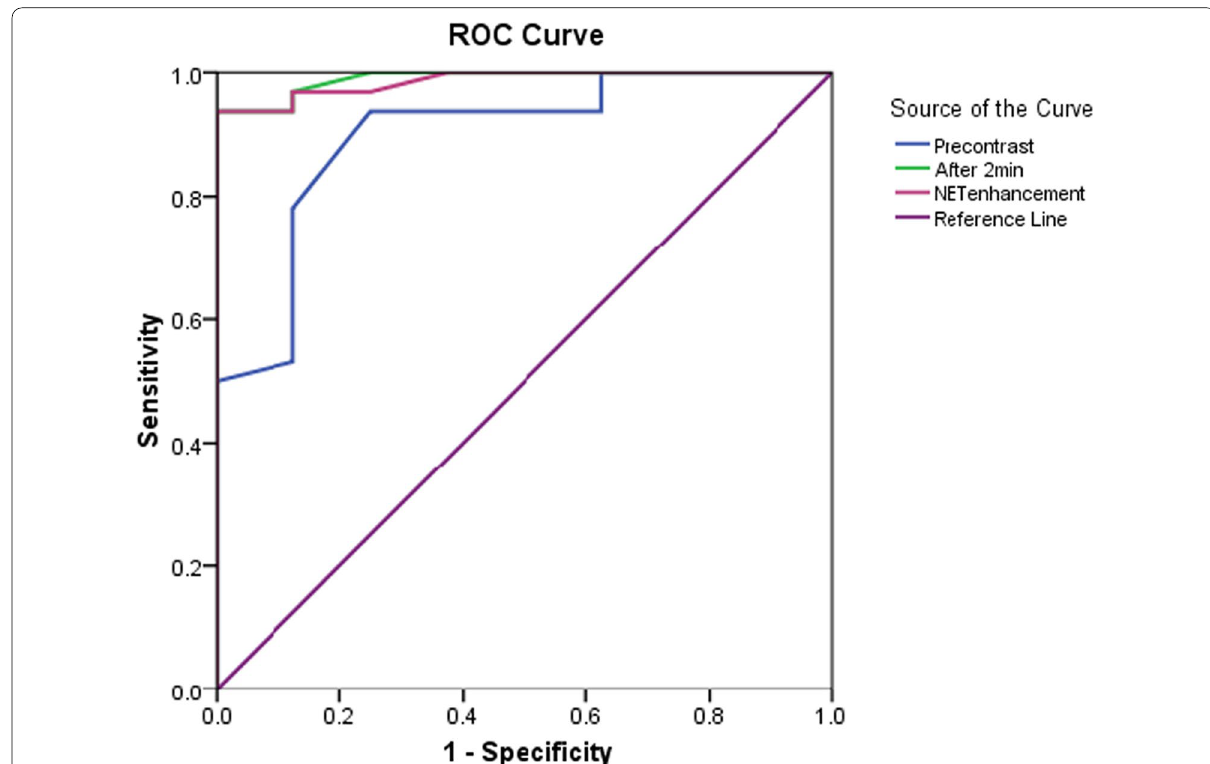
Fig. 4 ROC curve showing the cutoff point, sensitivity, specificity and accuracy of the pre enhancement, peak enhancement and net enhancement values in differentiating benign from malignant pulmonary